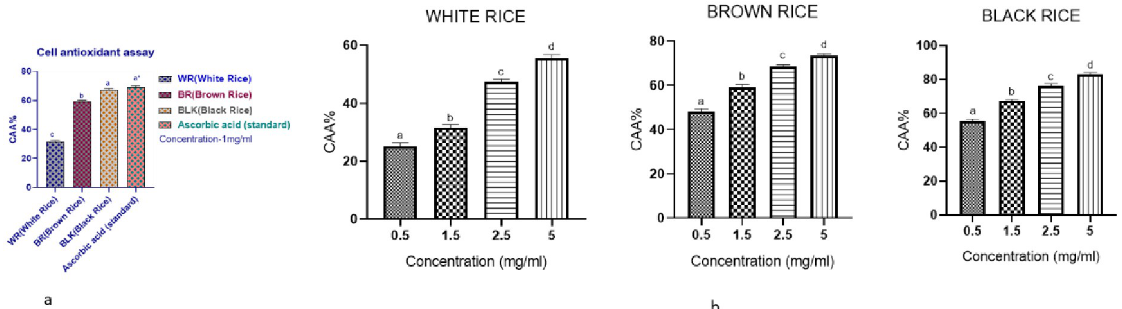
Fig 2. (A) CAA graph of rice extracts at 1 mg/mL. (B) Rice extracts at 0.5–5 mg/mL inhibited peroxyl radical-induced DCFH oxidation to DCF and ROS production in Caco-2 cells. Using one-way ANOVA, the data were reported as means ± standard deviations (n = 3). Tukey’s test at p < 0.05 shows significant differences between the columns using different alphabets (a–d). Note: (DCFH: 2’,7’–dichlorofluorescein diacetate, DCF: 2’, 7’–dichlorofluorescein, ROS: Reactive oxygen species, CAA- Cell antioxidant